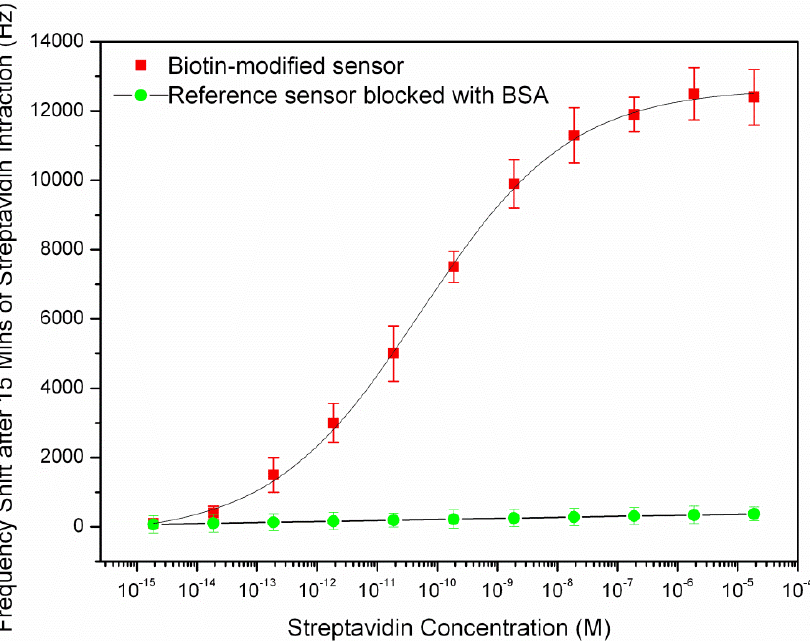
Figure 6. The streptavidin fraction in the solution and corresponding sensor frequency shifts after 15 min of interaction with biotin. The standard deviation in these experiments shown is based on many rounds of the frequency measurements after bonding the streptavidin with coated